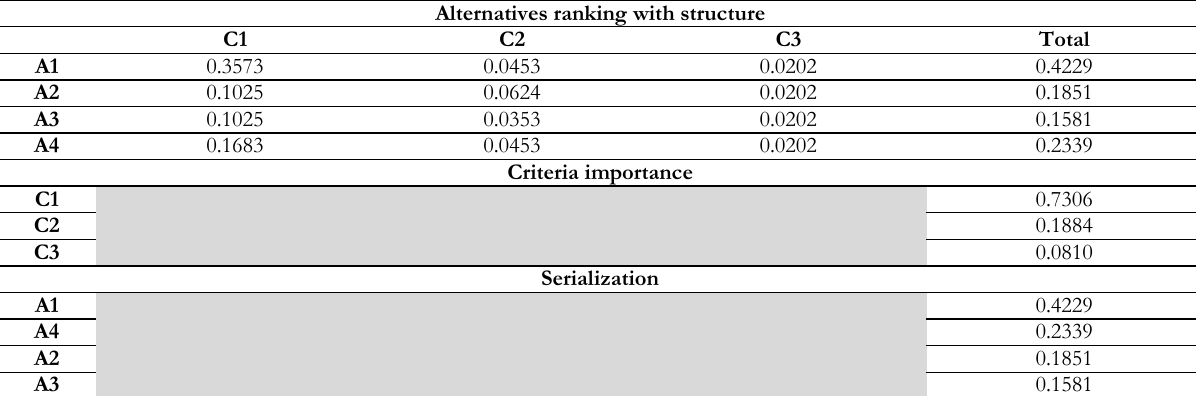
Table 4. Applying AHP method to scenario IV